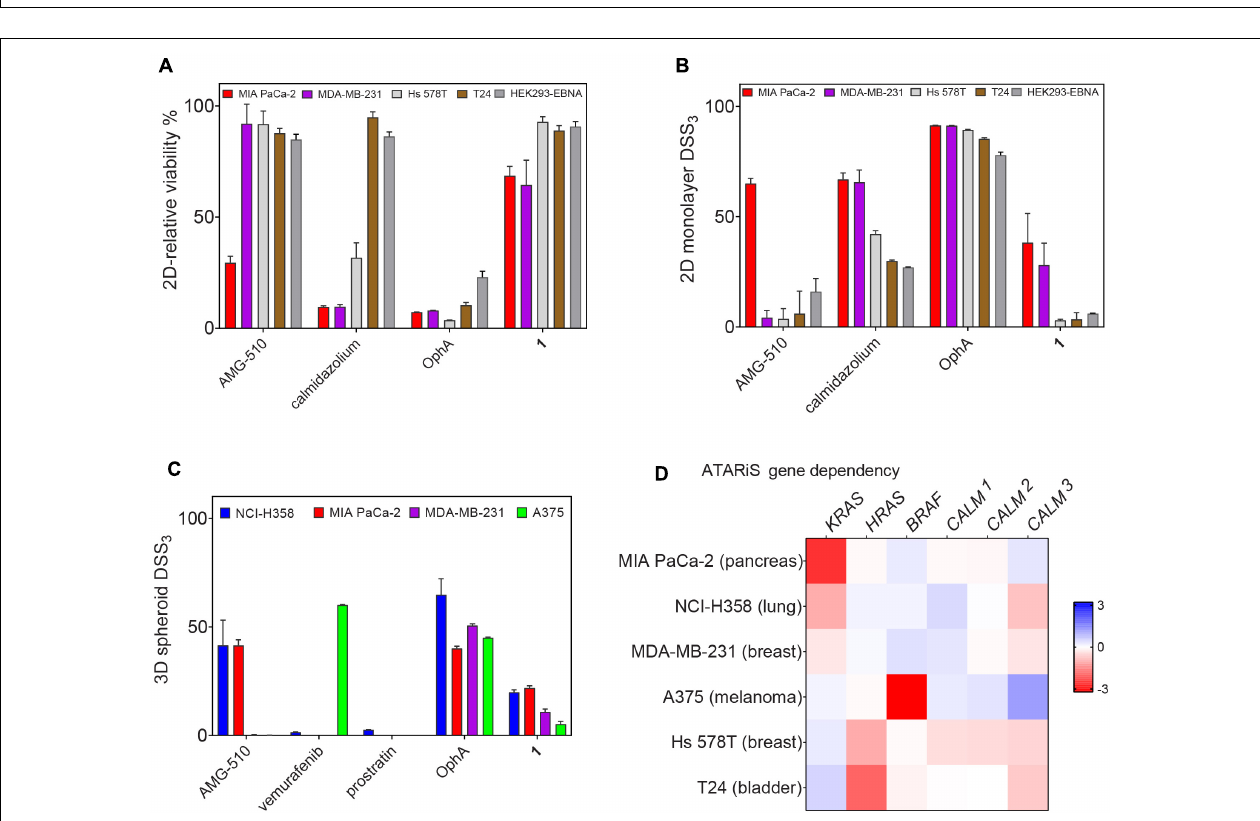
FIGURE 6 | Benchmarking of top compound 1 in several cancer cell lines. (A) The relative 2D viability of various cell lines following single dose treatment with AMG-510 (1 µ M), calmidazolium (2.5 µ M), OphA (1 µ M), and 1 (10 µ M) was assessed using the alamarBlue assay. Cells were grown as 2D adherent monolayers overnight and then treated for 72 h with indicated compounds. Data represent mean values ± SD, n ≥ 3. (B) DSS 3 measuring the effects of AMG-510 (0.003–40 µ M), calmidazolium (0.3–40 µ M), OphA (0.3–40 µ M), and 1 (0.6–80 µ M). Cells were grown as 2D adherent monolayers overnight and then treated for 72 h. Results represent mean values ± SD, n = 3. (C) DSS 3 measuring the effects of AMG-510 (0.6–40 µ M), vemurafenib (0.3–20 µ M), prostratin (0.6–80 µ M), OphA (0.3–20 µ M), and 1 (1.3–80 µ M). Cells were grown as 3D spheroids for 72 h then treated with compounds for another 72 h before alamarBlue viability measurements. Data represent mean values ± SD, n ≥ 2. (D) Heatmap of ATARiS gene sensitivity scores obtained from the project DRIVE database for KRAS-dependent cell lines (MIA PaCa-2, NCI H358, and MDA-MB-231) and HRAS-dependent cell lines (Hs 578T and T24). Negative values (red) indicate sensitivity of the cell line proliferation to the knockdown of shown genes, while positive (blue) indicates the